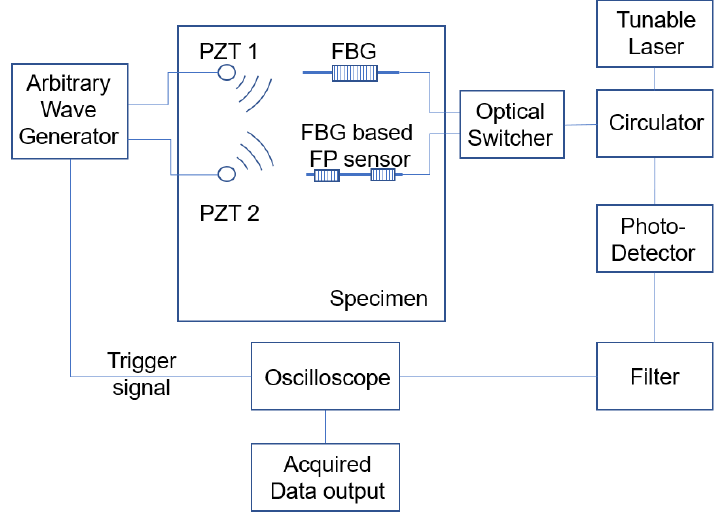
Figure 10. Schematic diagram of the hybrid system.